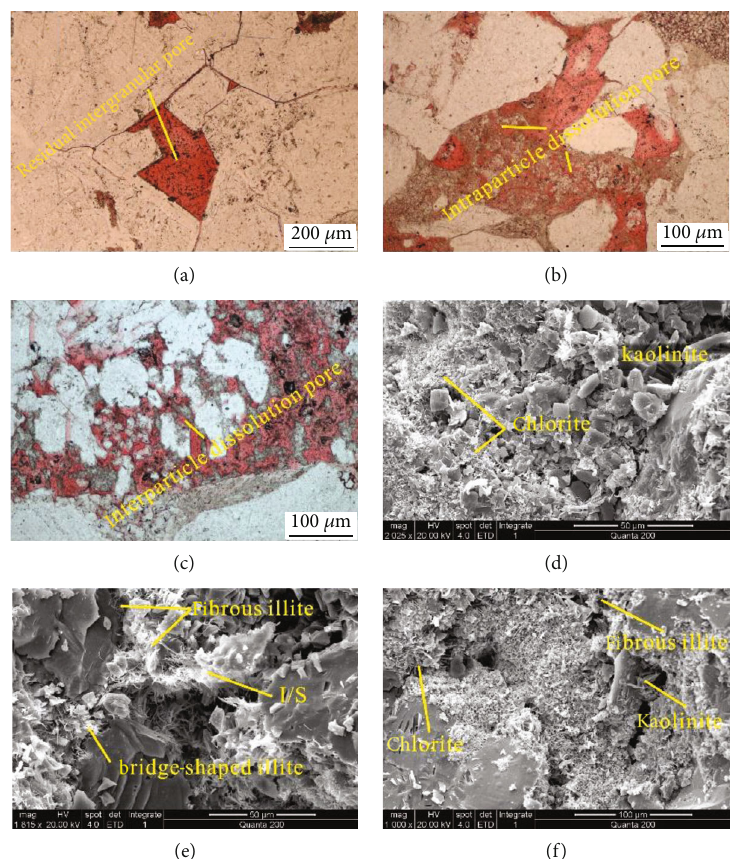
Figure 3: Typical images from the TS and SEM: (a) abundant residual intergranular pores; (b) intraparticle feldspar dissolution pores; (c) interparticle feldspar dissolution pores; (d) the surfaces of the rock particles are covered with rosette-shaped chlorite and the pores are fi lled with vermicular-shaped kaolinite; (e) the surfaces of the rock particles are covered with the I/S mixed layer, fi brous, and bridge- shaped illite; (f) chlorite, kaolinite, and kaolinite began to develop to shrink pores and